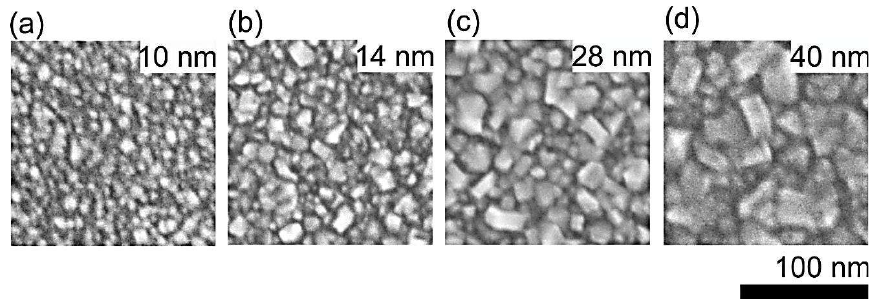
Figure 1. Representative scanning electron microscopy (SEM) images of ultra-thin nanocrystalline diamond (NCD) films having thicknesses of 10 nm ( a ), 14 nm ( b ), 28 nm ( c ), and 40 nm ( d ).